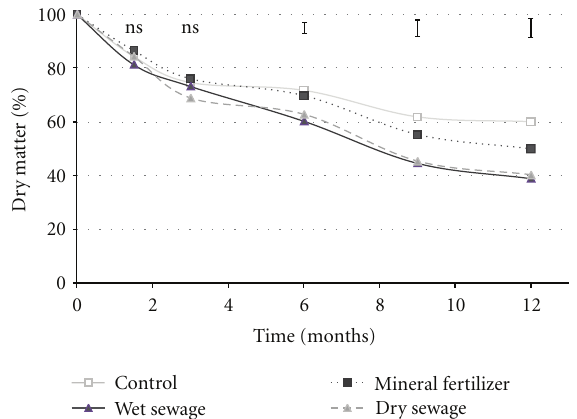
Figure 3: Dry matter (%) of leaf litter remaining after di ff erent times of decomposition within the litter bags distributed on the forest floor in the 4 treatments (time zero was October 2004). Vertical bars represent the minimum significant value ( P < . 05) and ns means not